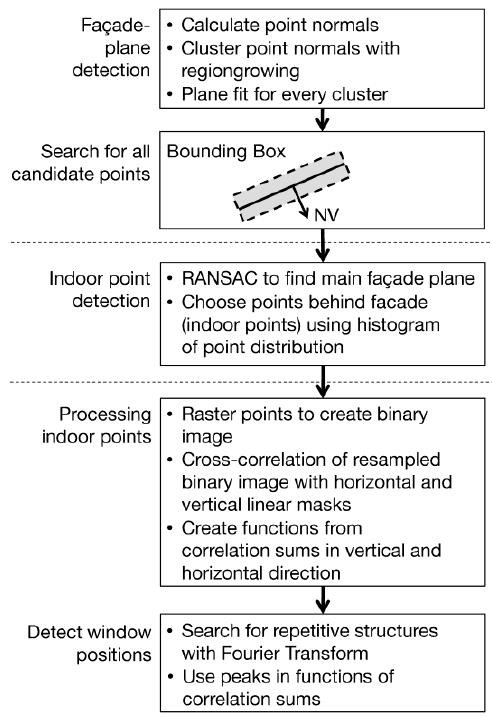
Figure 2. Flowchart of the presented approach